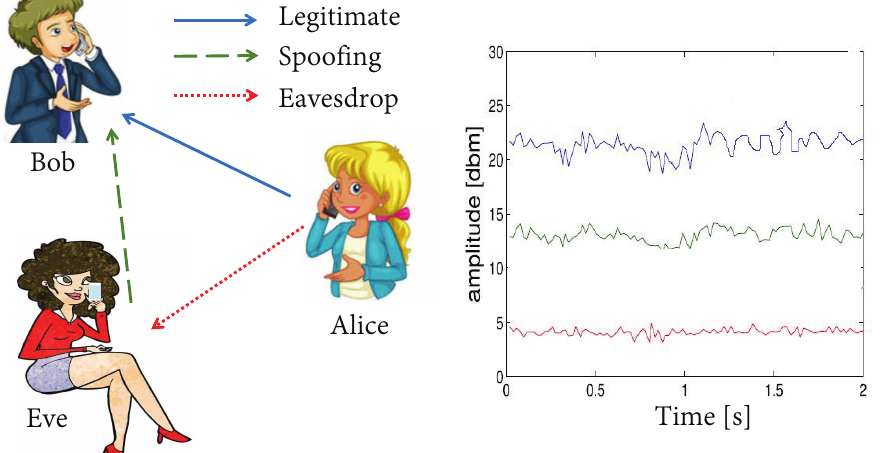
Figure 1. Security authentication system between Alice and Bob based on physical layer